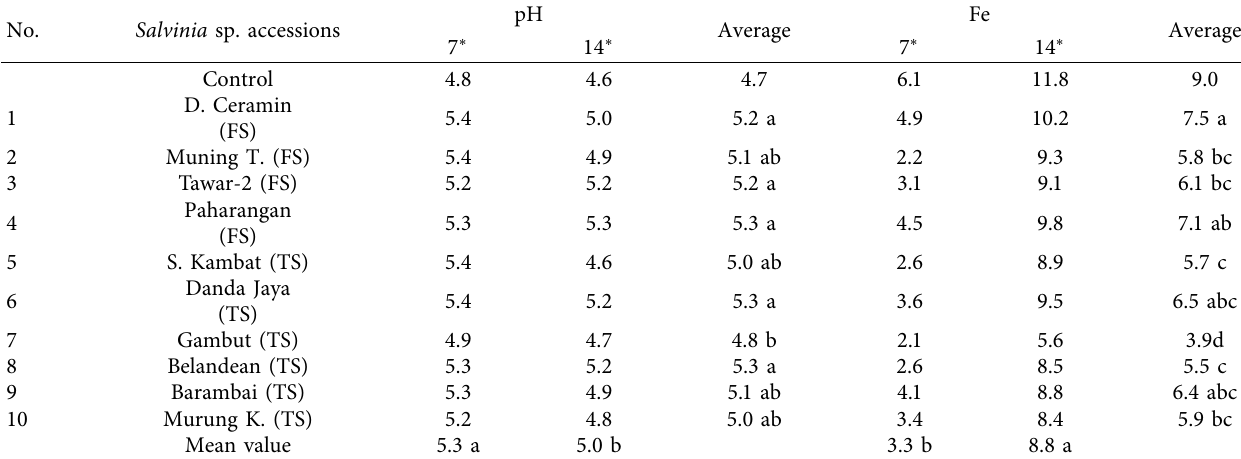
Table 4: The change of pH and Fe concentration in Hoagland nutrient solution after enriched with 7 and 14 ppm Fe during 2 weeks of Salvinia sp. growth.